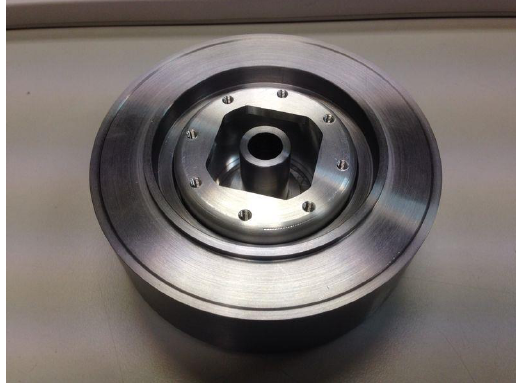
Figure 7. External and internal parts.